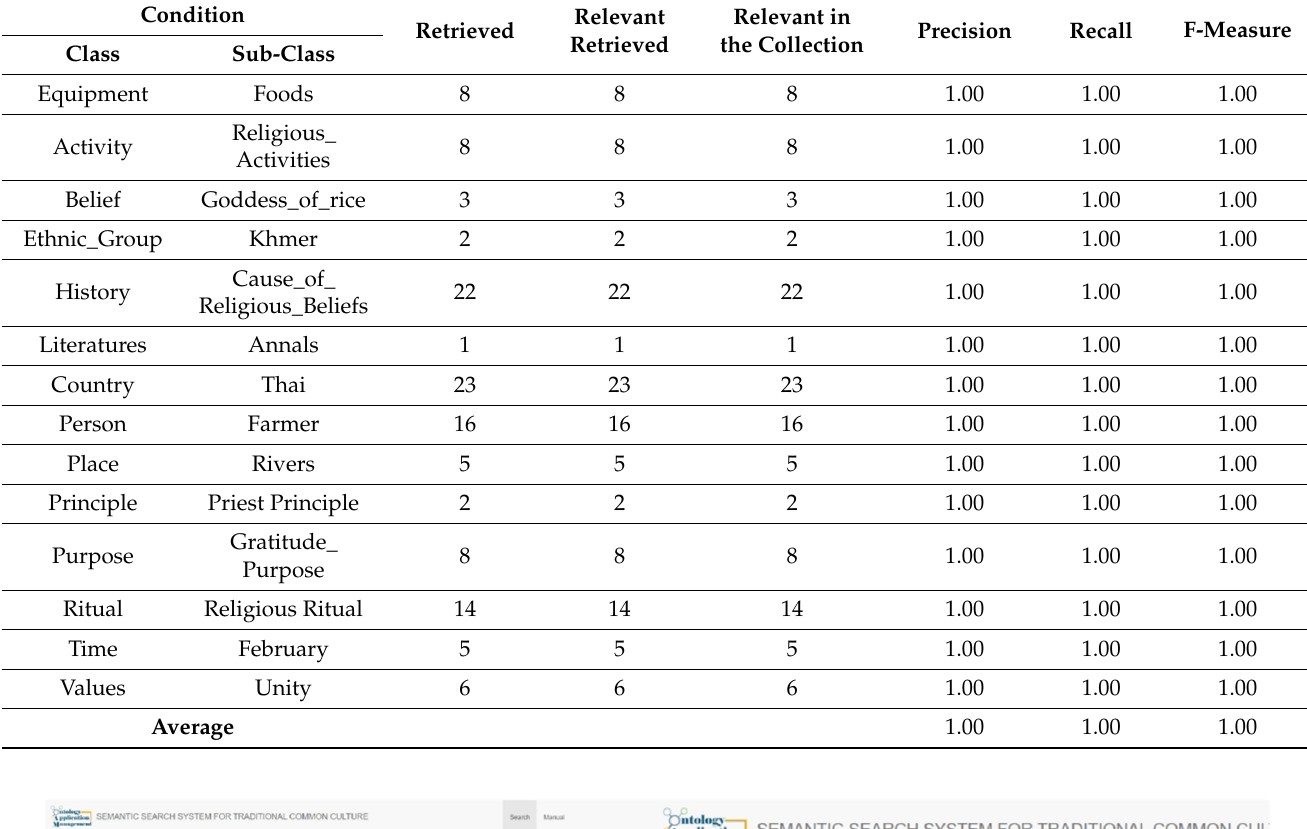
Table 5. The performance of the semantic information retrieval system with advanced search.